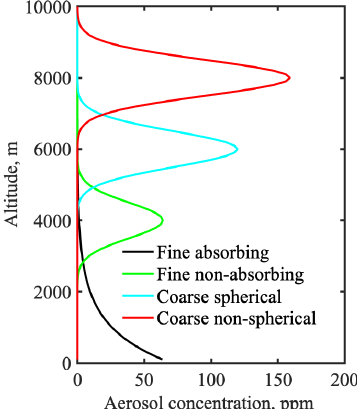
Figure 30. Aerosol vertical distribution used for the simulation in the LILAS sensitivity test.